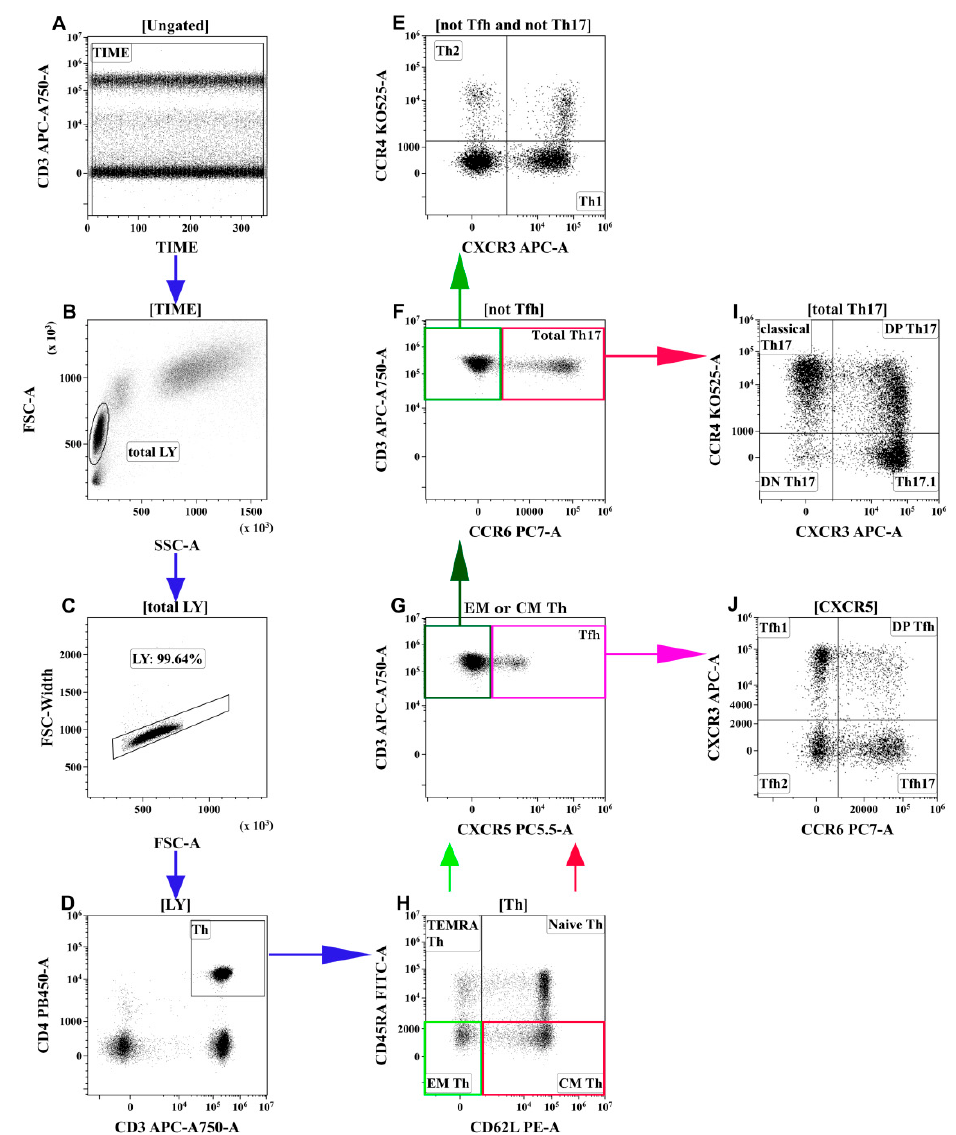
Figure 1. Flow cytometry immunophenotyping gating strategy for Th subsets. ( A ) Artifact exclusion included time gating. ( B ) FSC vs. SSC gating to discriminate lymphocytes and cell debris. ( C ) Doublet exclusions from the analysis using